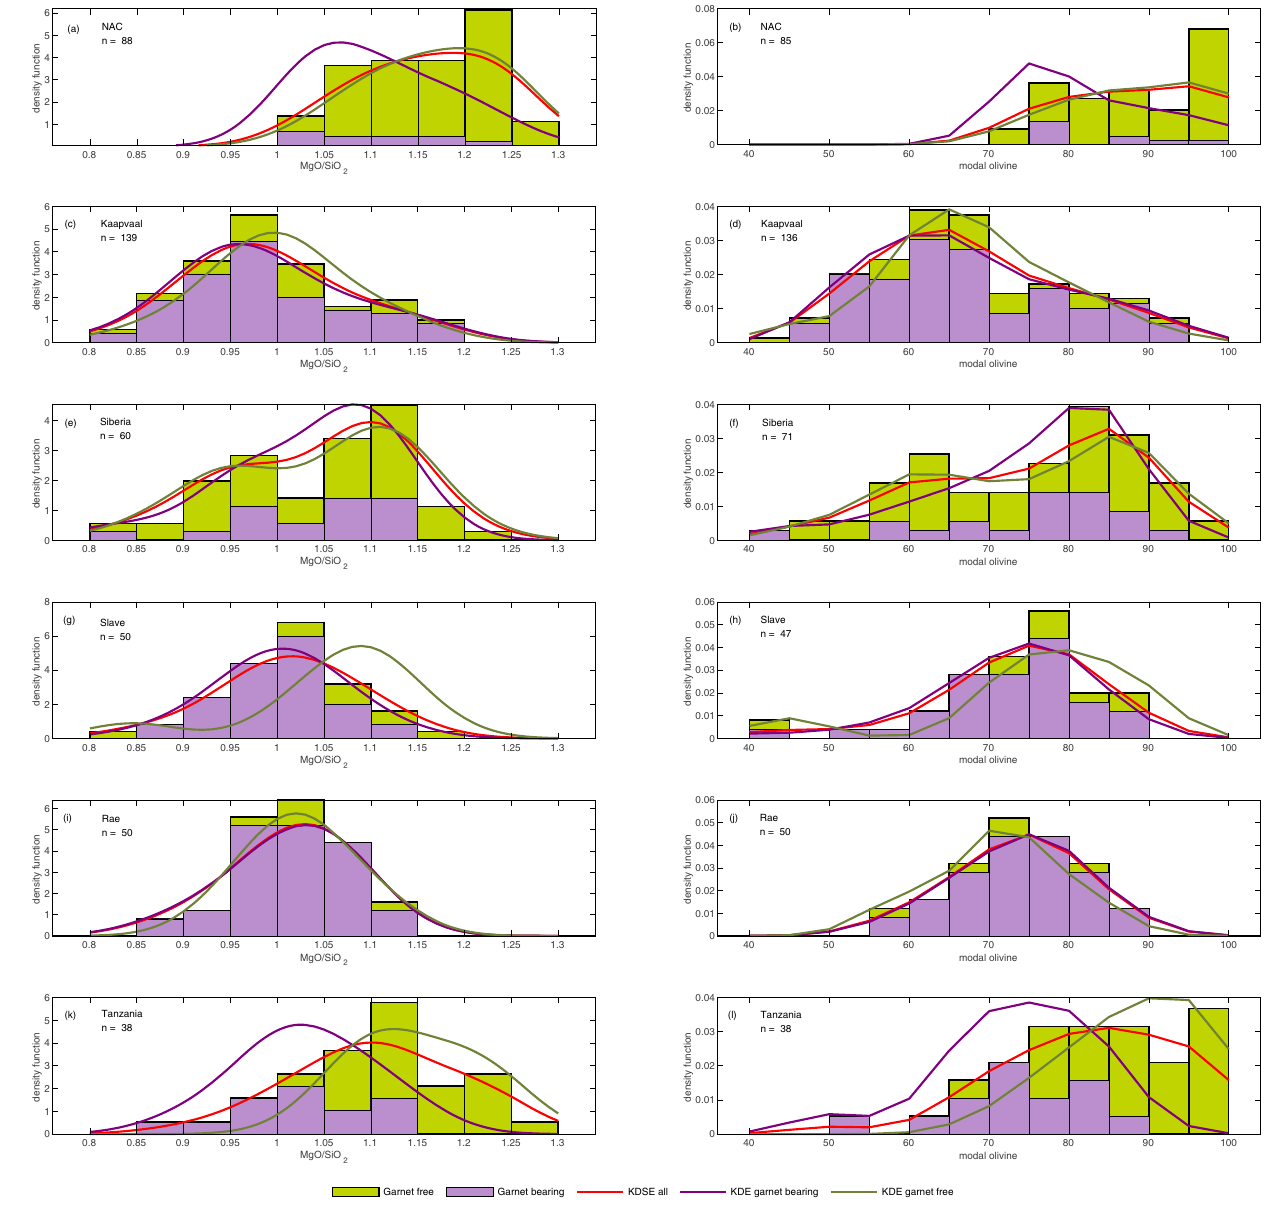
Fig. 2 Normalised stacked histograms and Kernel Distribution Estimations for xenoliths from the studied Archaean cratons. MgO/SiO2 (left, bandwidth = 0.05) and modal olivine (right, bandwidth = 5) in garnet-bearing and garnet-free peridotites from NAC ( a - b ), Kaapvaal ( c - d ), Siberia ( e - f ), Slave ( g - h ), Rae ( i - j ) and Tanzania ( k - l ). See supplementary data 1 for full dataset. Discrepancies between the number of samples plotted in MgO/SiO2 and modal olivine re fl ect differences in data types presented in different